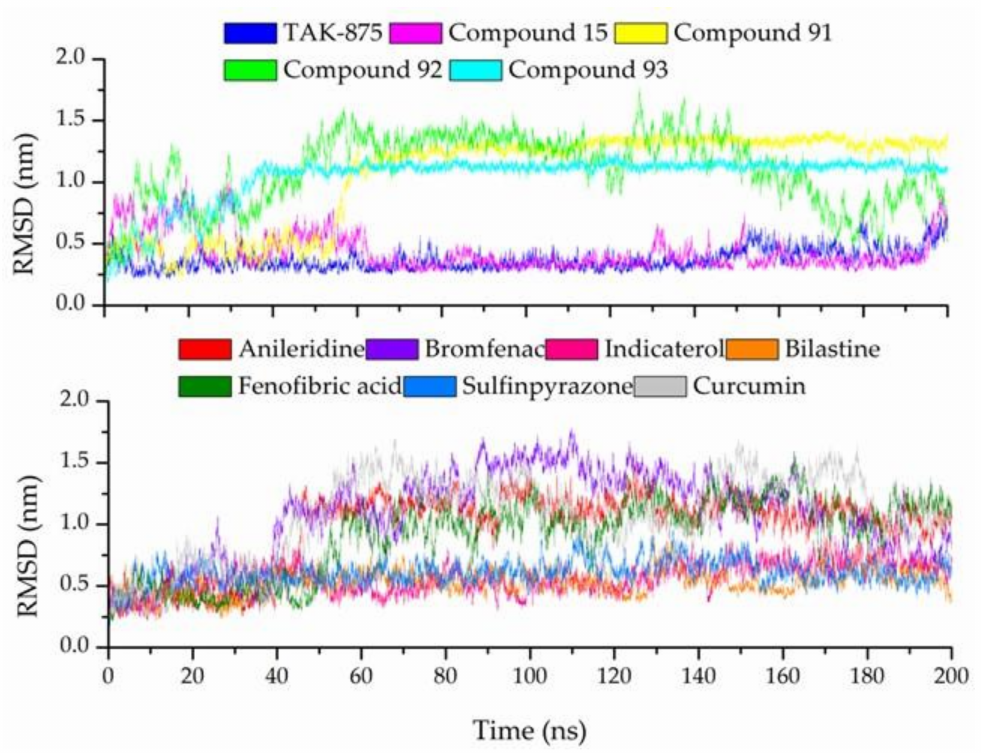
Figure 7. RMSD of ( top ) FFA1 in complex with the ligands of the dataset ( top ) and of the screening ( bottom ) during the 200 ns of MD simulation.